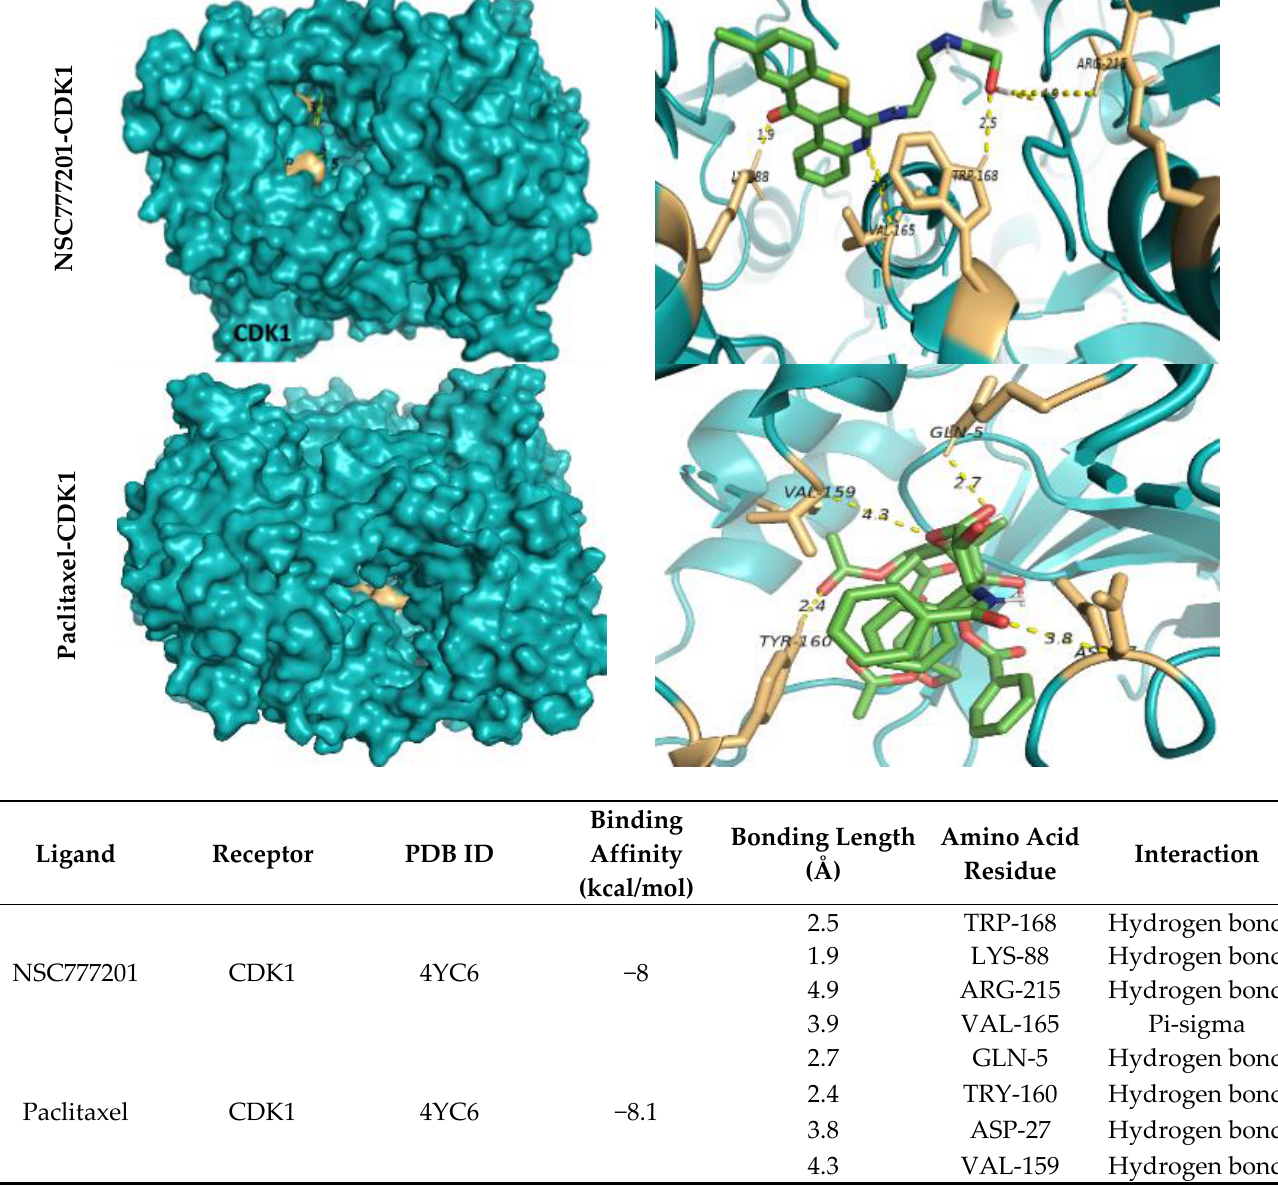
Table represents the ligand receptor-interacting atoms, binding affinities, and interacting distances of NSC777201 and CDK1. Figure 9. Docking profile of CDK1 with NSC777201 and paclitaxel (a known inhibitor). 3D structure of ligand-receptor interactions shown in the left panel. The right panel shows the 2D representation of the interaction with ligands and the receptors in the binding pocket.